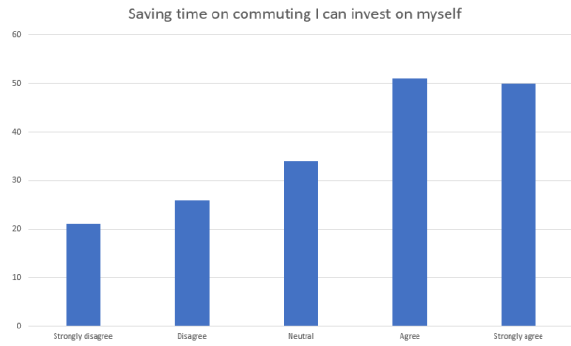
Fig 2. Importance of choice of location (International Workplace Group, 2019).